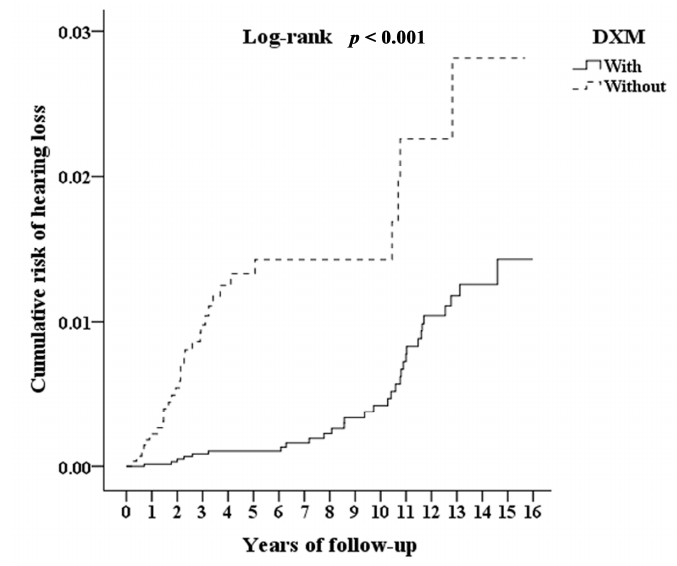
Figure 5. Kaplan–Meier for cumulative risk of hearing loss among individuals aged > 40 with or without DXM use.